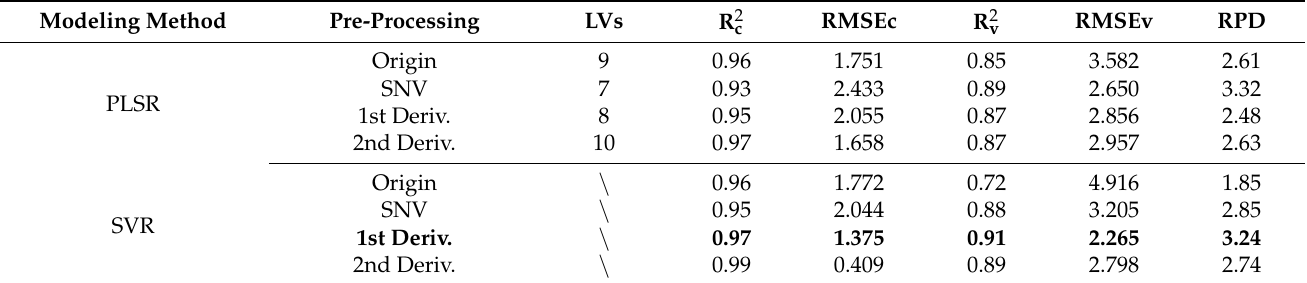
Table 2. AFB 1 prediction results of models with Box-Cox